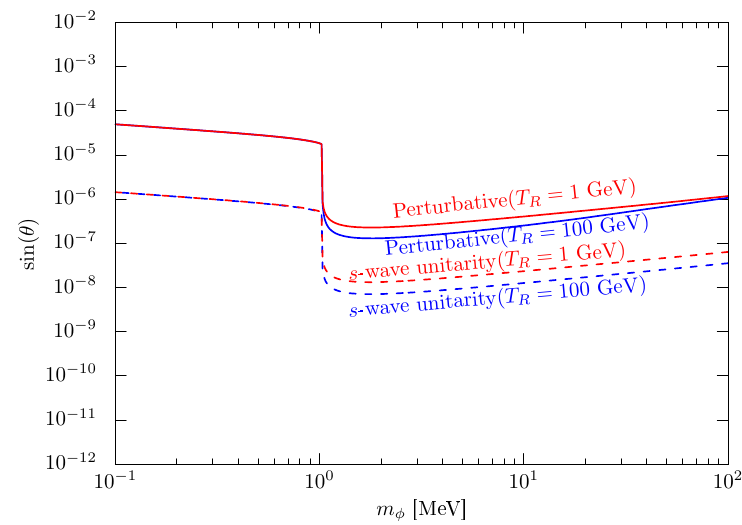
Figure 16. The parameter region in which the self-thermalization effect is valid. Above the lines the self-thermalization is maintained until the dark scalar decay time or the CMB